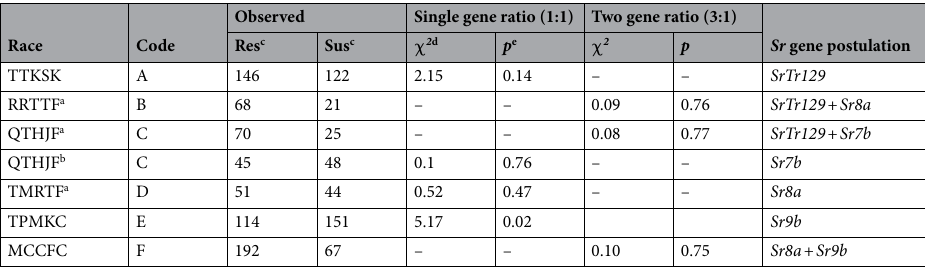
Table 1. Phenotypic ratios, chi squared analysis and Sr gene postulation for response to six Puccinia graminis races tested on the RL6071/Tr129 DH population. a Phenotypic data for a random subset of the DH population (Subset 1). b Phenotypic data for a subset of lines lacking resistance to race A (Subset 2). c Res resistant, Sus susceptible. d Chi-squared value. e p-value for the chi-squared value.